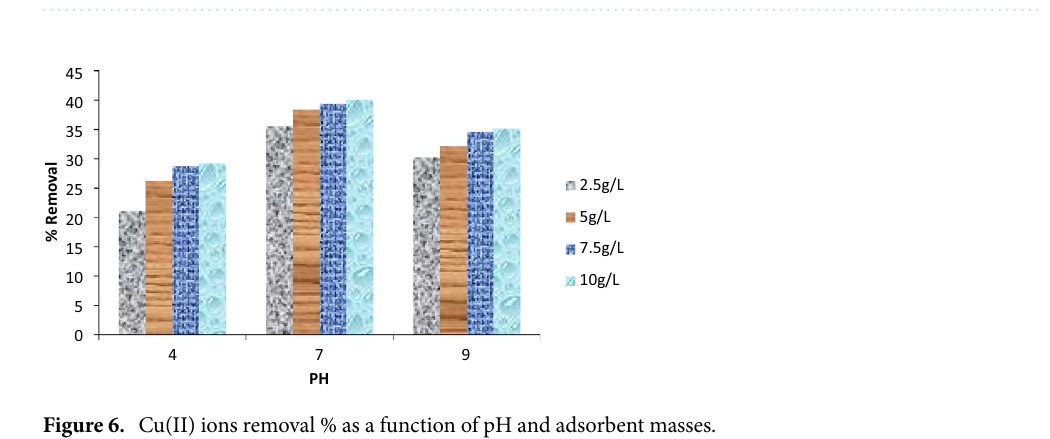
Figure 6. Cu(II) ions removal % as a function of pH and adsorbent